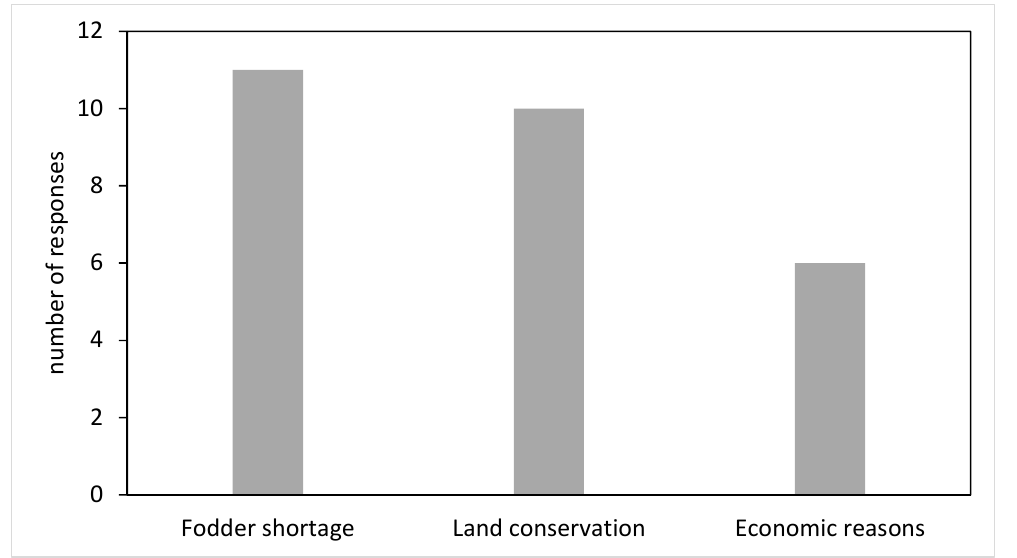
Figure 2. Main triggering factors for adopting forage tTechnologies; multiple responses possible ( n = 20).